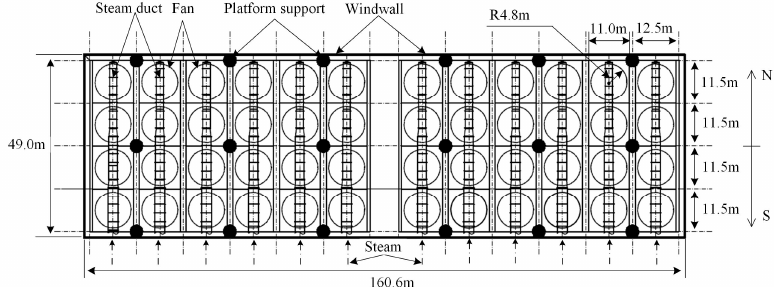
Figure 1. The top view of the DACC (direct air-cooled condensers).